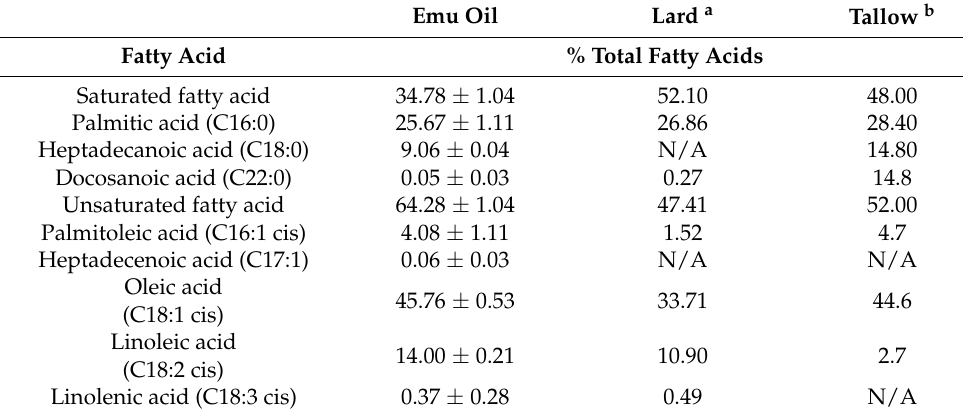
Table 2. Fatty acid composition of emu